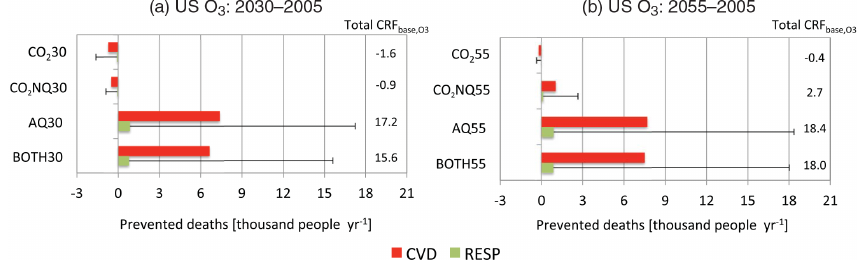
Figure 6. Impact of the air quality regulations and CO 2 reduction policy on US mortality related to ozone. It is important to note that the color bar shows the mortality rate using CRF low , O only includes RESP. It has a unit of thousand people per year. The total mortality rate using CRF base , O